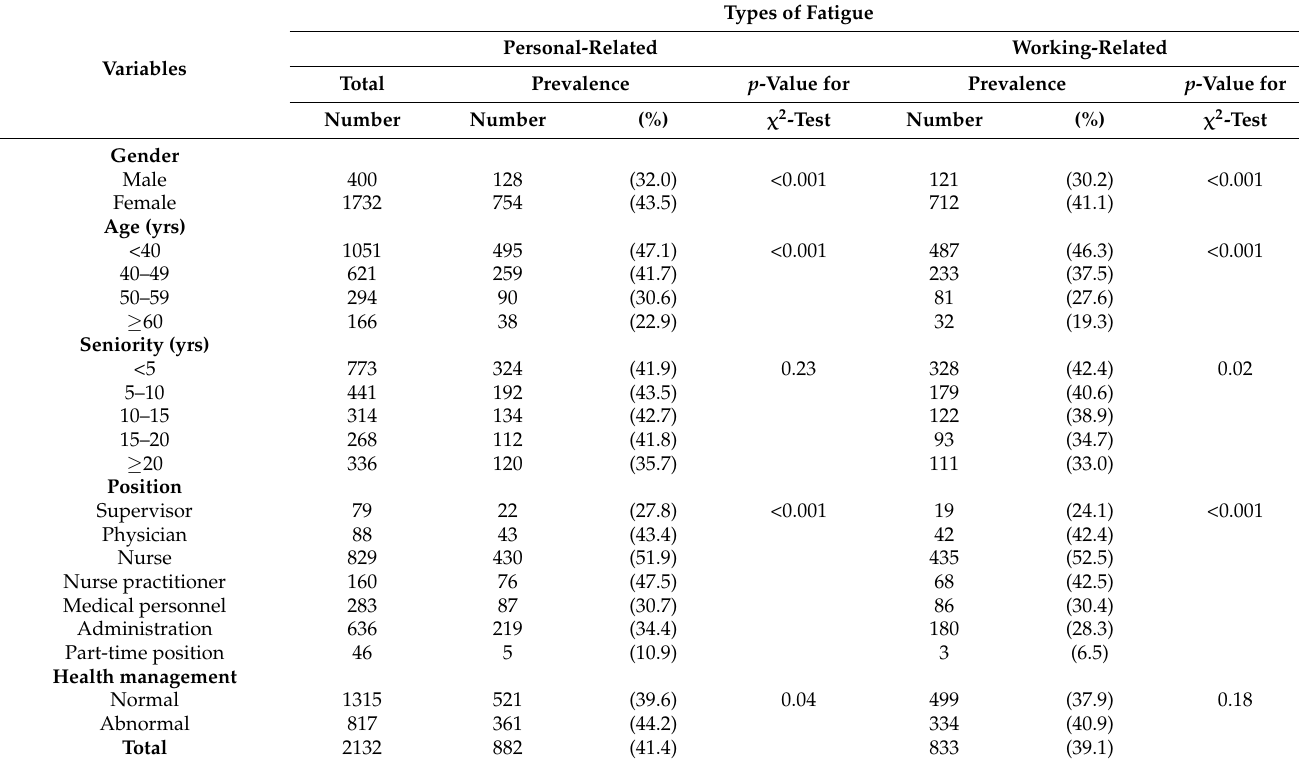
Table 1. The prevalence of each type of fatigue among the study population ( n = 2132).